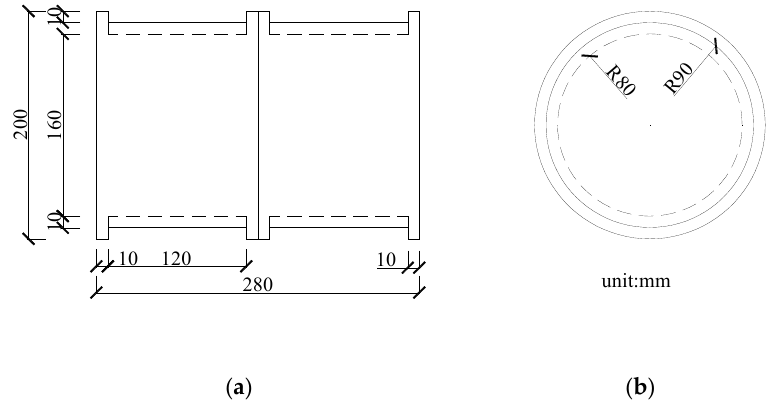
Figure 3. Sketch of aluminum pipe model: ( a ) segments are tighten by the bolts against the flange; ( b ) sensor.